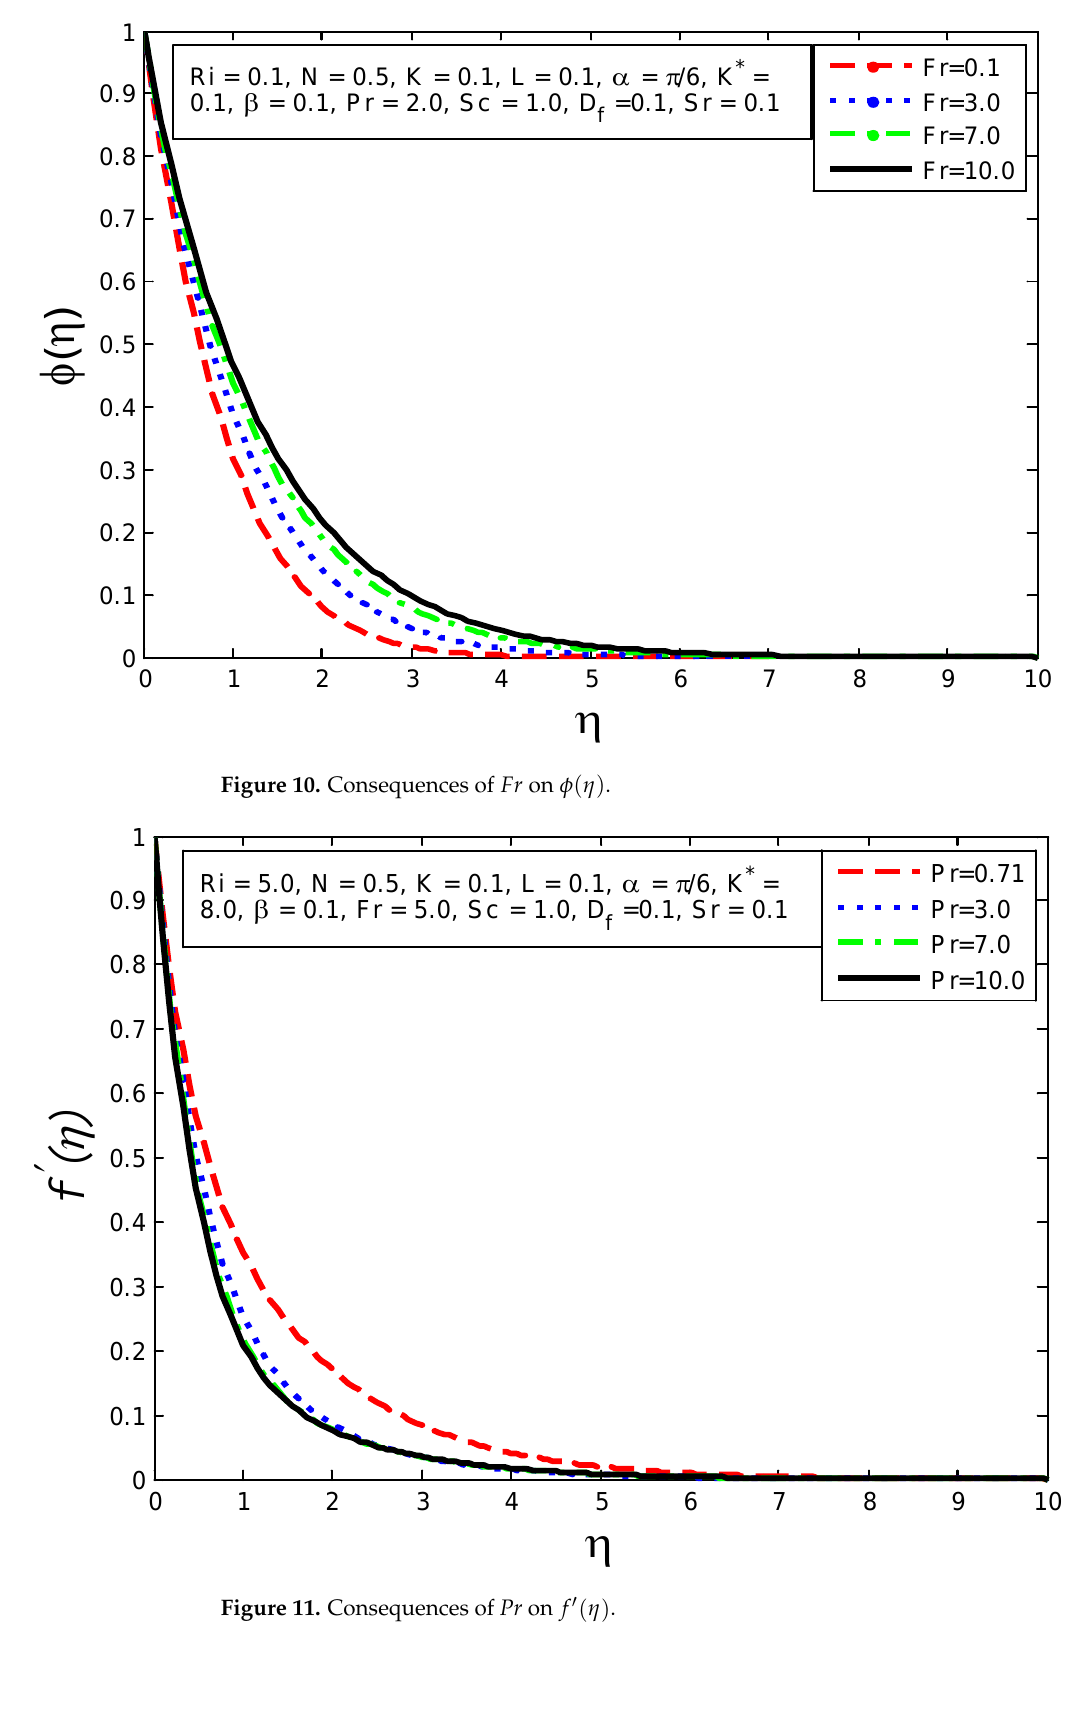
Figure 12. Consequences of Pr on 𝜃𝜃 ( 𝜂𝜂 ) .